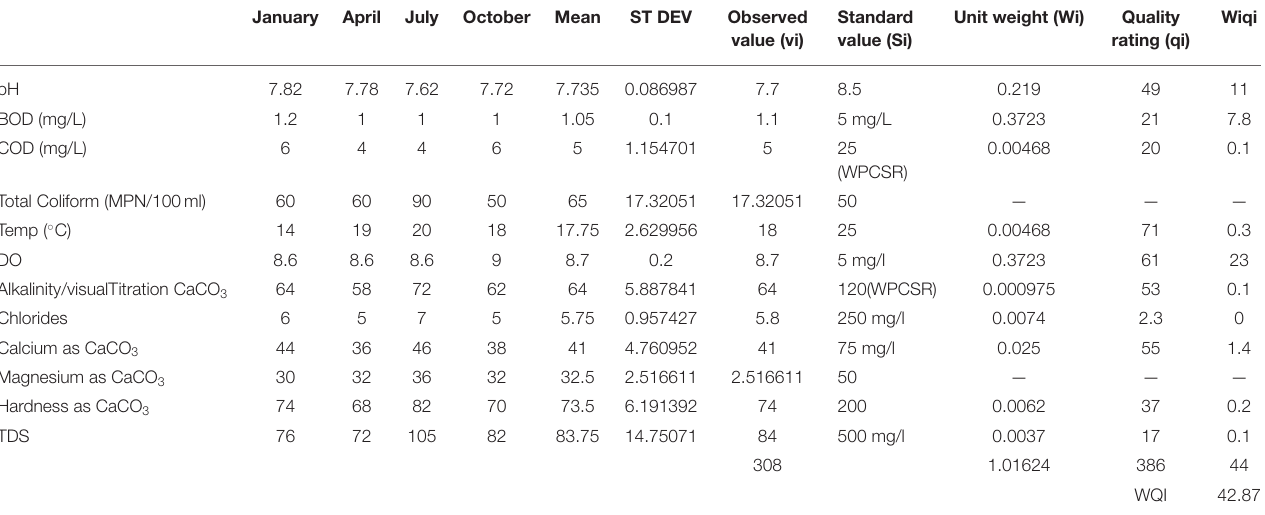
TABLE 2 | Physicochemical parameters and water quality analysis at Dehradun for